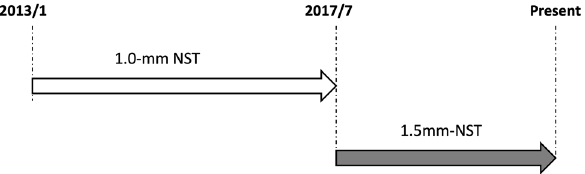
Figure 3. Composition of the ND and LD groups. The ND and LD groups are indicated by the white gray arrows, respectively. The ND group consisted of patients treated with the 1.0-mm NST before the deployment of 2020). Abbreviation: NST, Nunchaku-style